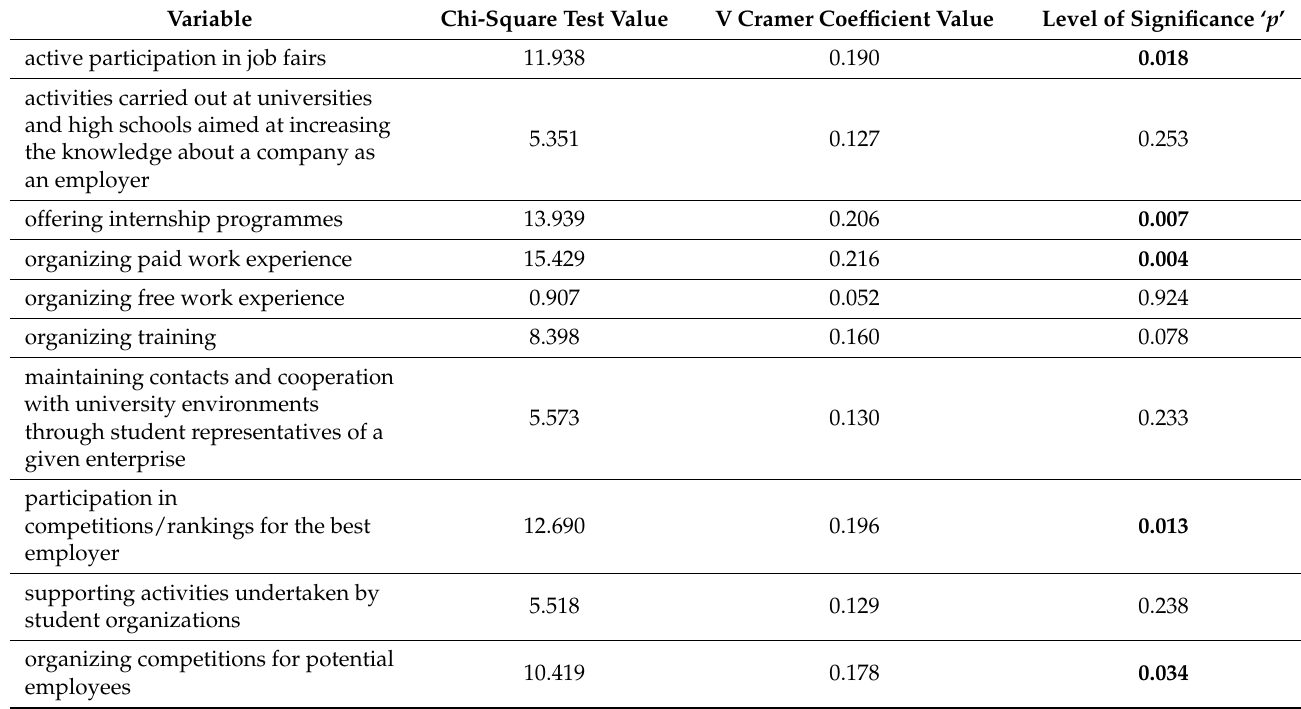
Table 5. Dependencies between respondents’ opinions on the impact of activities undertaken by enterprises on shaping their positive external image as an employer, and respondents’ opinions on whether the employer’s image created on the basis of modern marketing communication channels is more beneficial than the employer’s image created on the basis of classical marketing communication